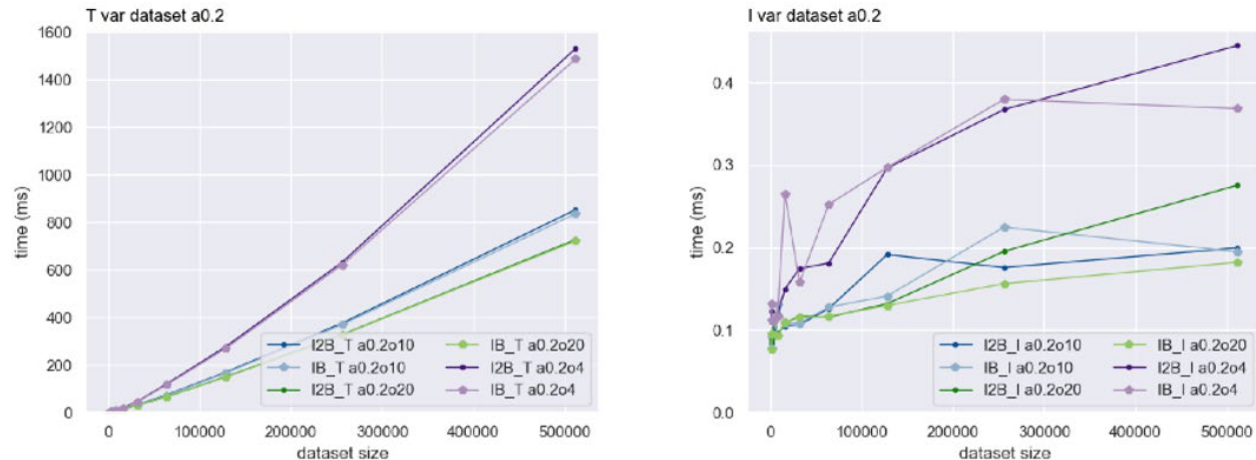
Figure 3. Tree construction test (left) and Insertion test (right), for the small intervals scenario , using an alpha parameter of